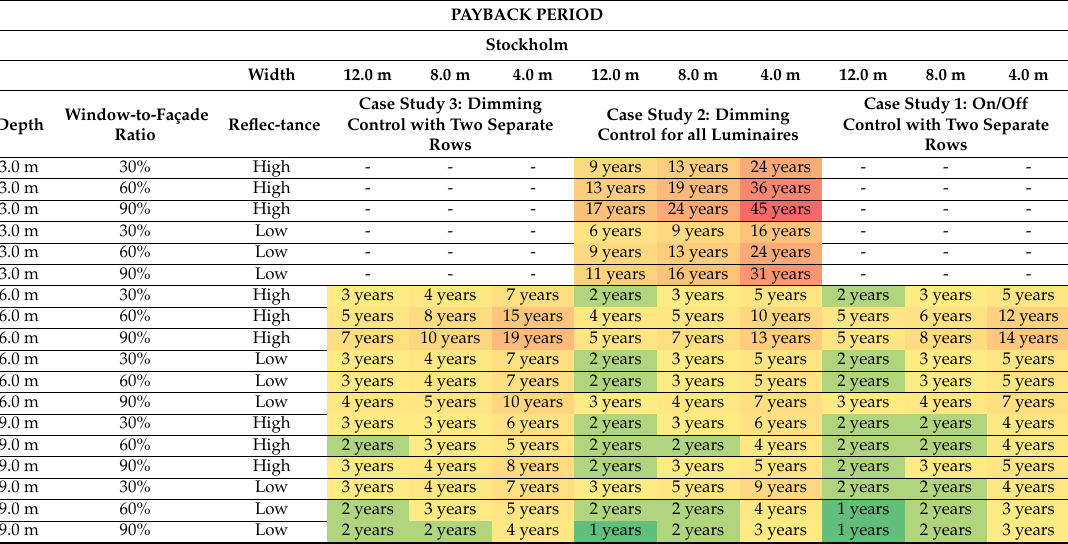
Table 12. Payback period according to different lighting smart controls in